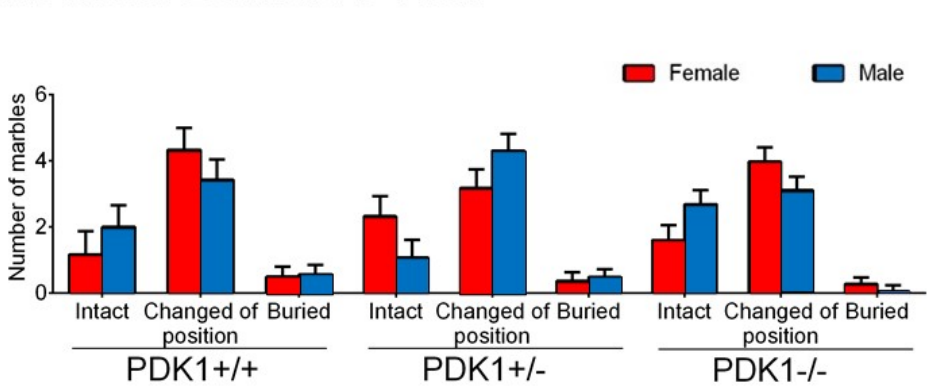
Figure 5. Marble burying test in female and male mature PDK1 − / − , heterozygous PDK1 +/ − and homozygous WT (PDK1 +/+ ) mice. Top panel: Data are expressed as mean ± SEM or incidence. Bottom panel: Individual data are depicted. Bars illustrate the genotype groups, as indicated in the Y-axis. Symbols illustrate the different groups or individual values, as depicted in the legends or abscissae. Factorial analysis: G, genotype effect; S, sex effect; all p > 0.05, n.s.